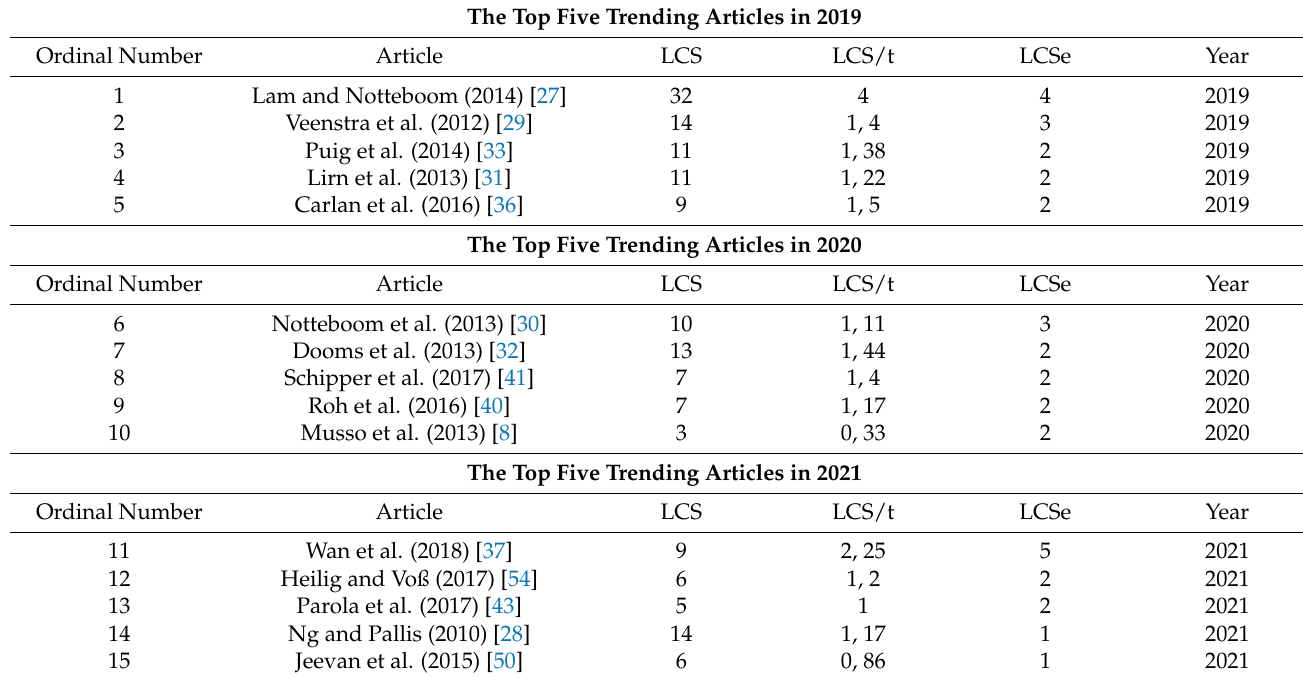
Table A2. The top five trending articles of the last three years of the bibliometric